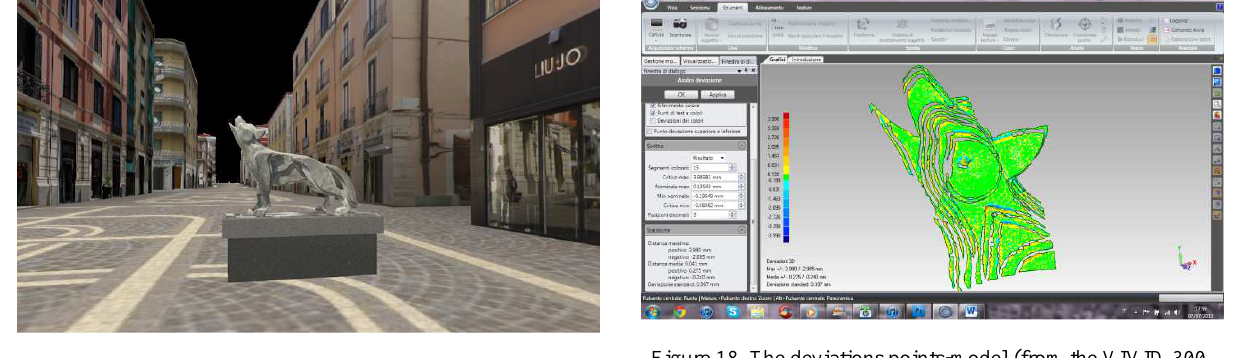
Figure 14. The model of the Wolf of Sila with C10 scans in the city model